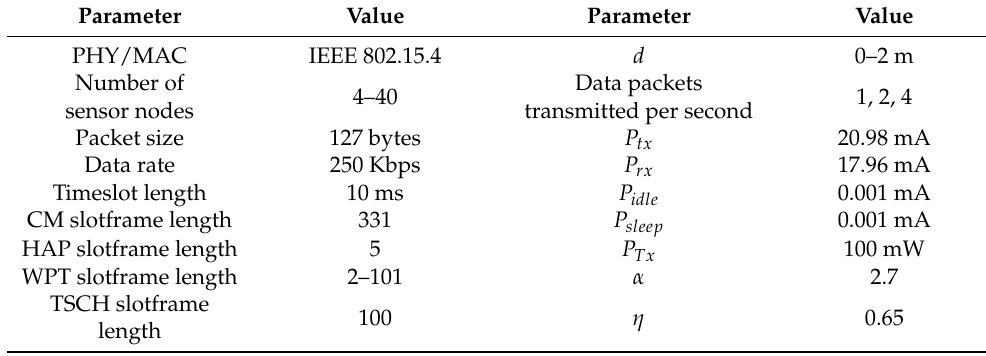
Table 1. Simulation